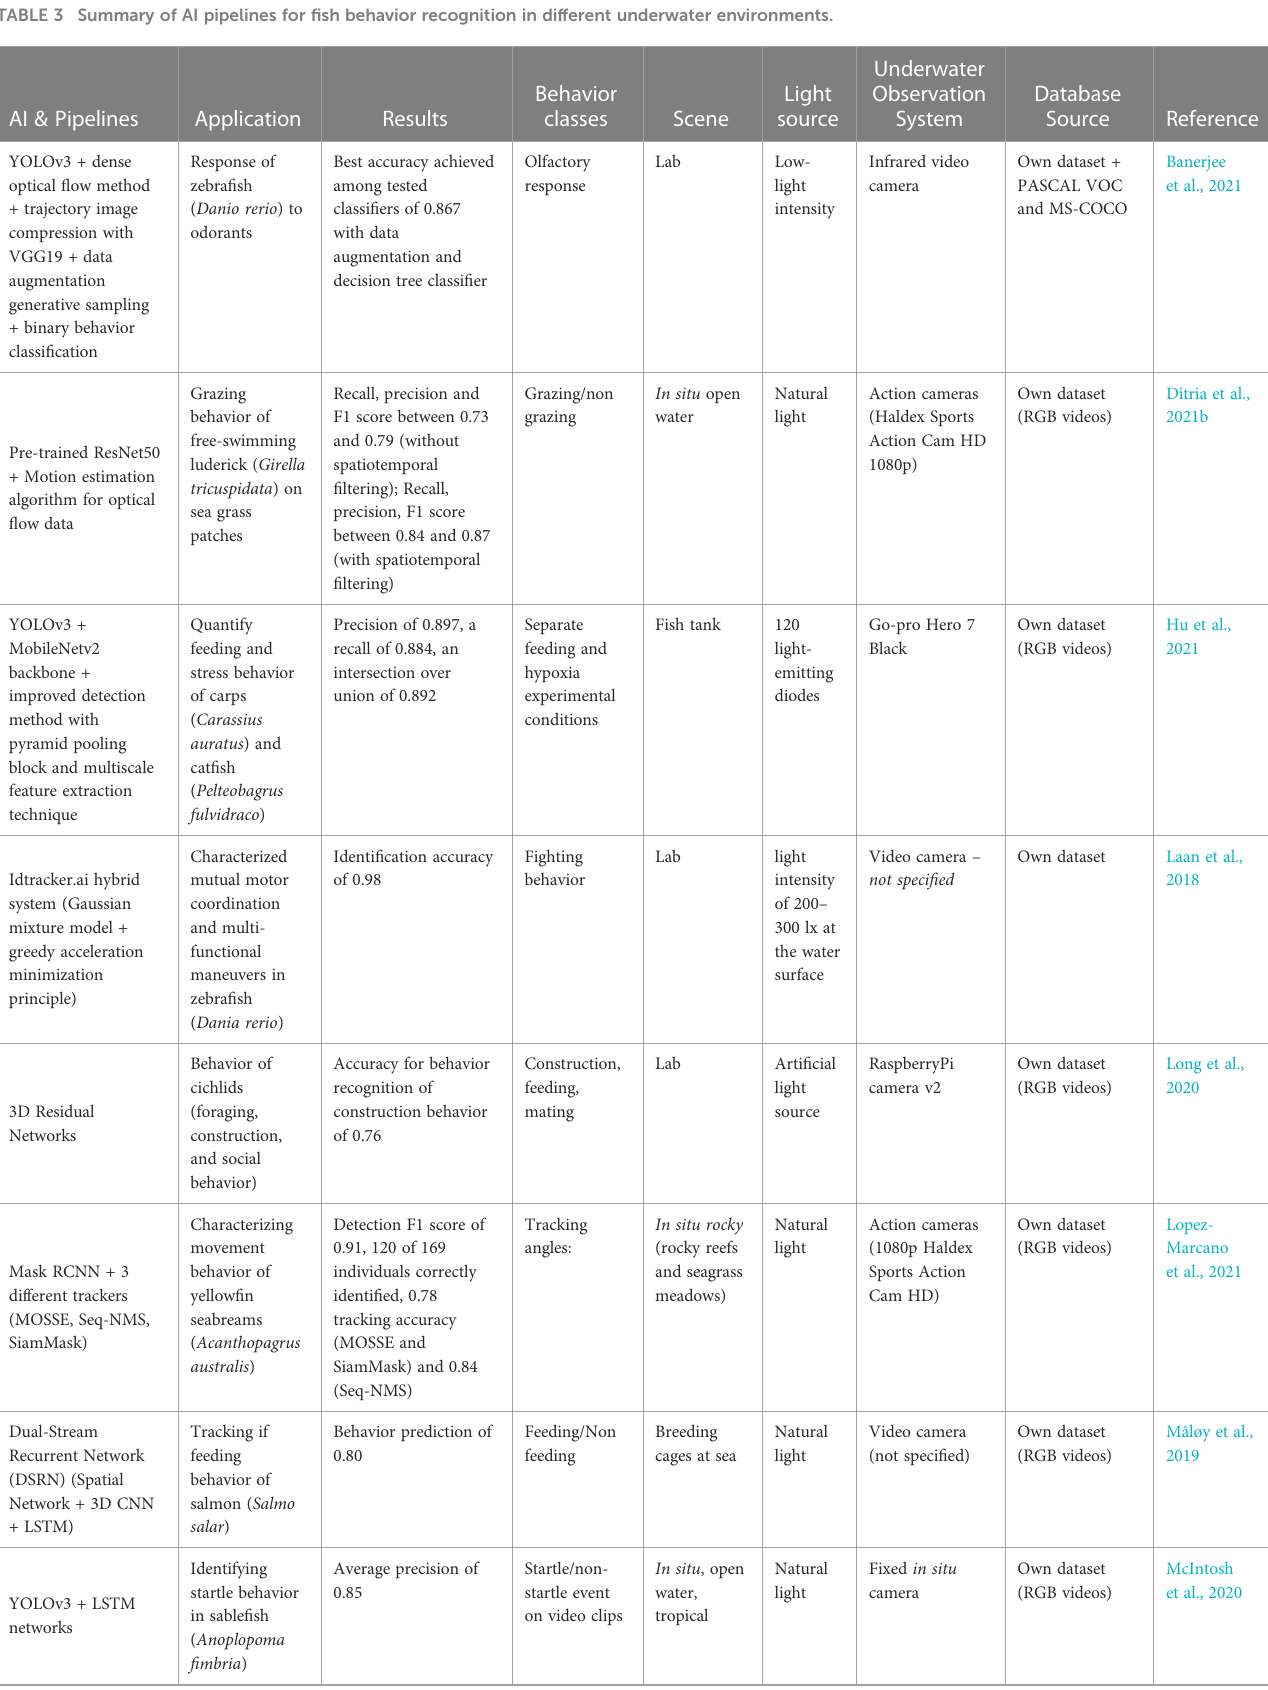
TABLE 3 Summary of AI pipelines for fi sh behavior recognition in different underwater